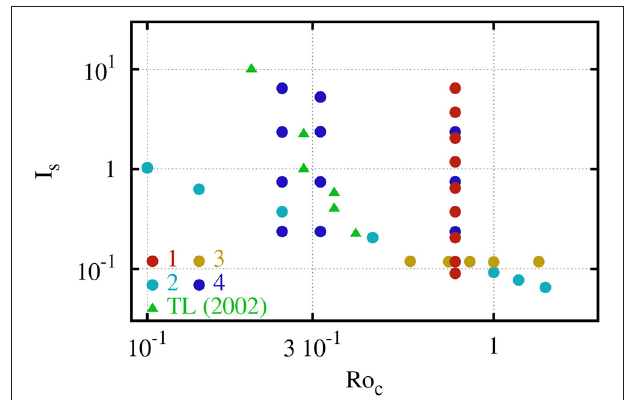
FIGURE 2 | Regime diagram of the numerical models from Table 1 sorted by their respective convective Rossby ( Ro c ) and the stratification relative to rotation rate ( I s ). The colors indicate simulations from different groups. The green triangles mark the cases used in Takehiro and Lister (2002).